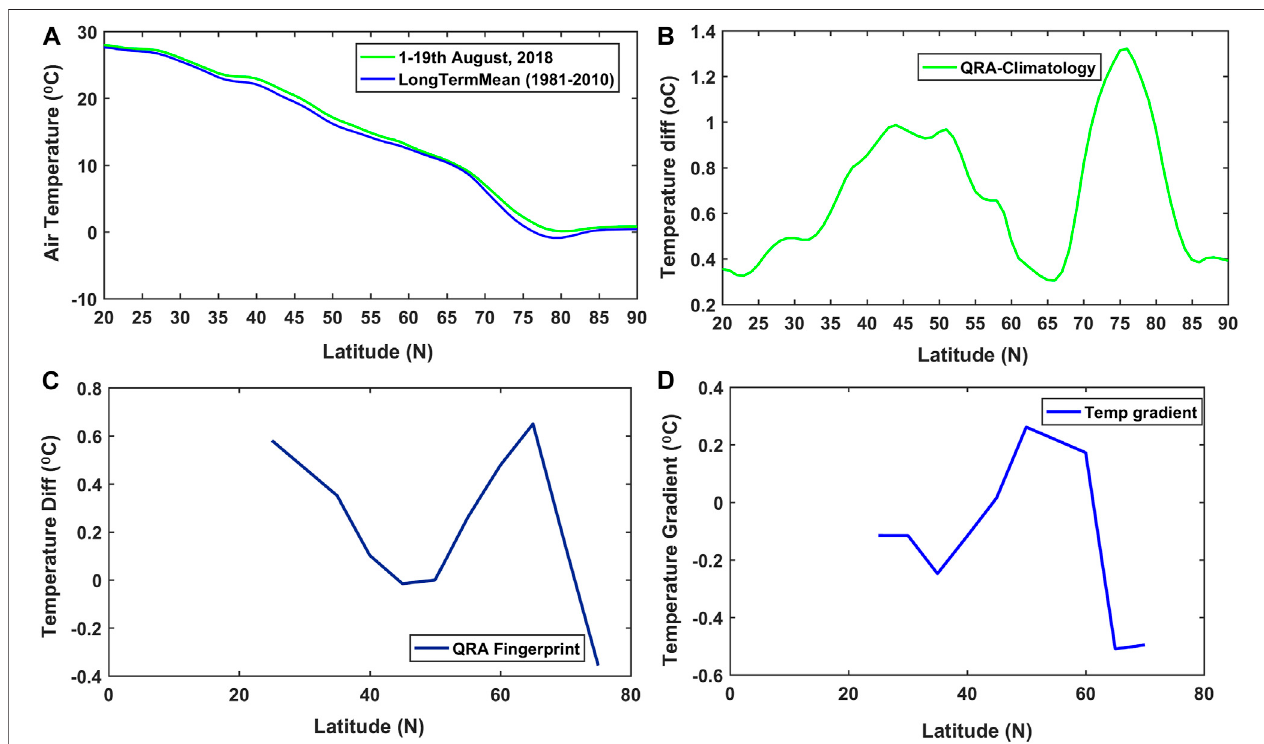
FIGURE 4 | (A) Meridional variations of zonal mean surface temperatures over NH (B) the difference between zonal mean temperatures associated with QRA favorable conditions (C) The QRA fi ngerprint and (D) Temperature gradient for each 5 over NH during 1 – 19th August 2018.